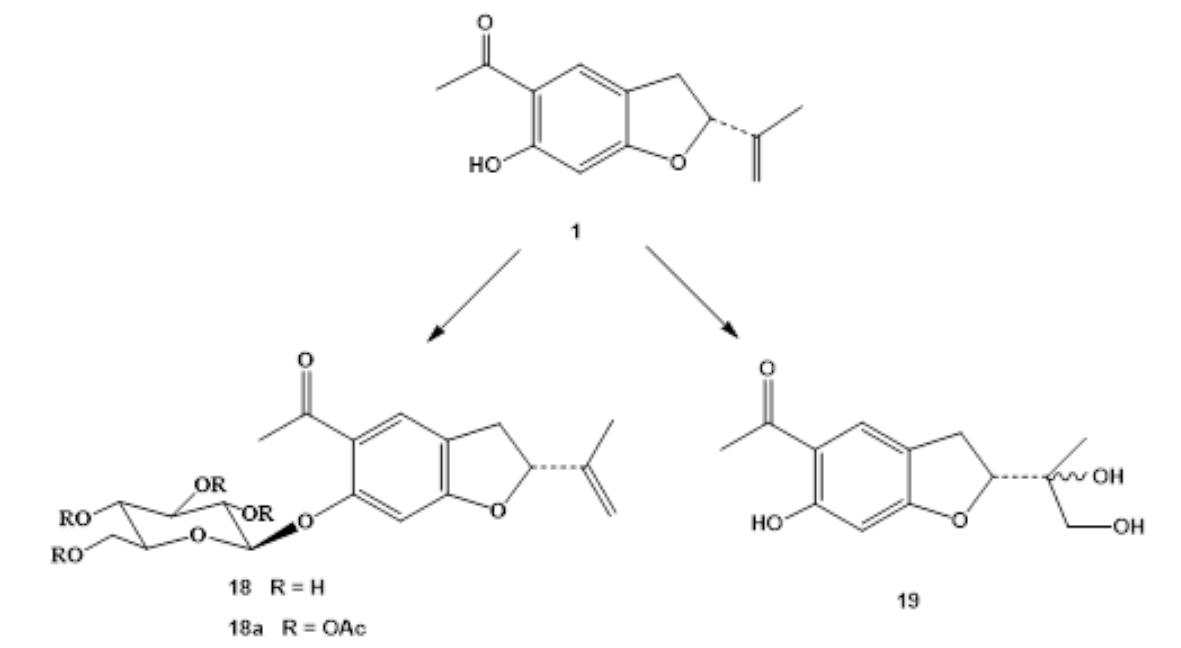
Figure 3. Biotransformation compounds of 1 by Mucor plumbeus